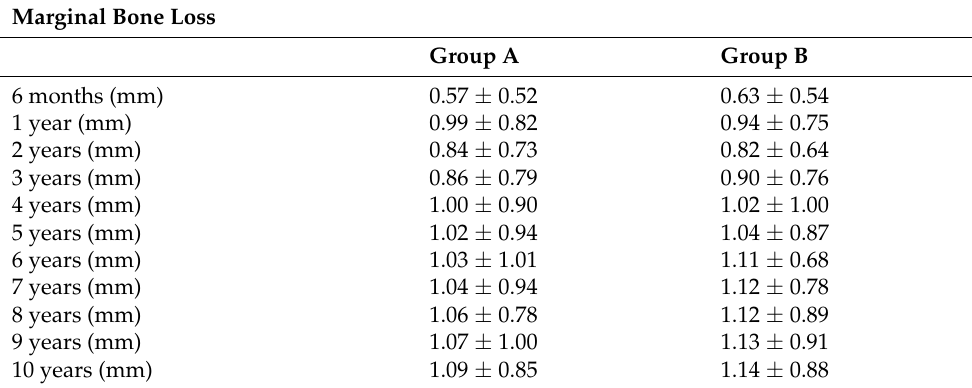
Table 3. Average marginal bone loss for each group during the follow-up.